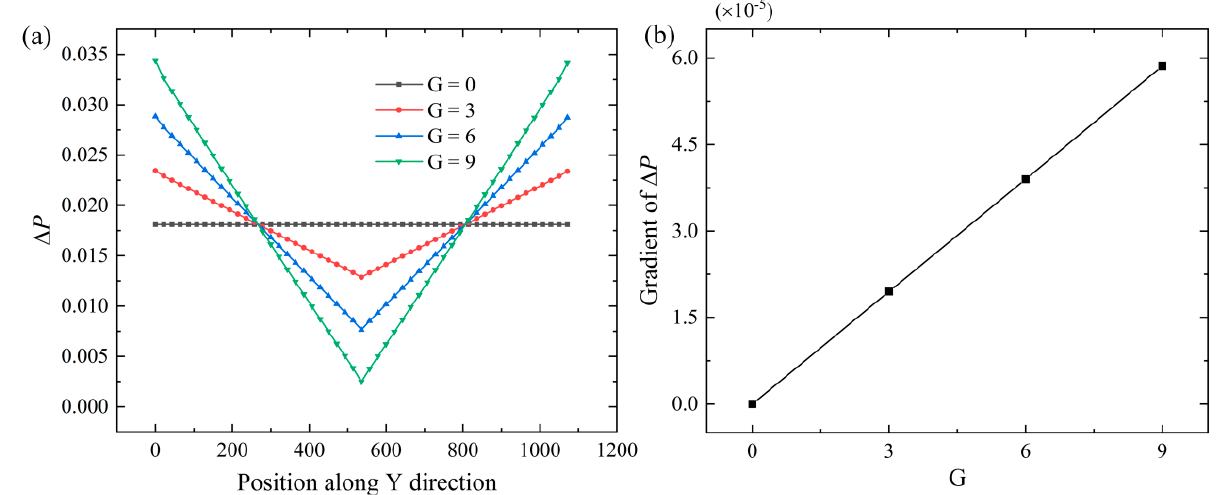
Figure 5. ( a ) Distribution of Δ P along the direction of the supergravity (the Y direction) with G = 0, 3, 6, and 9; ( b ) relationship between the gradient of Δ P (absolute value) and G , showing a good linear correlation.